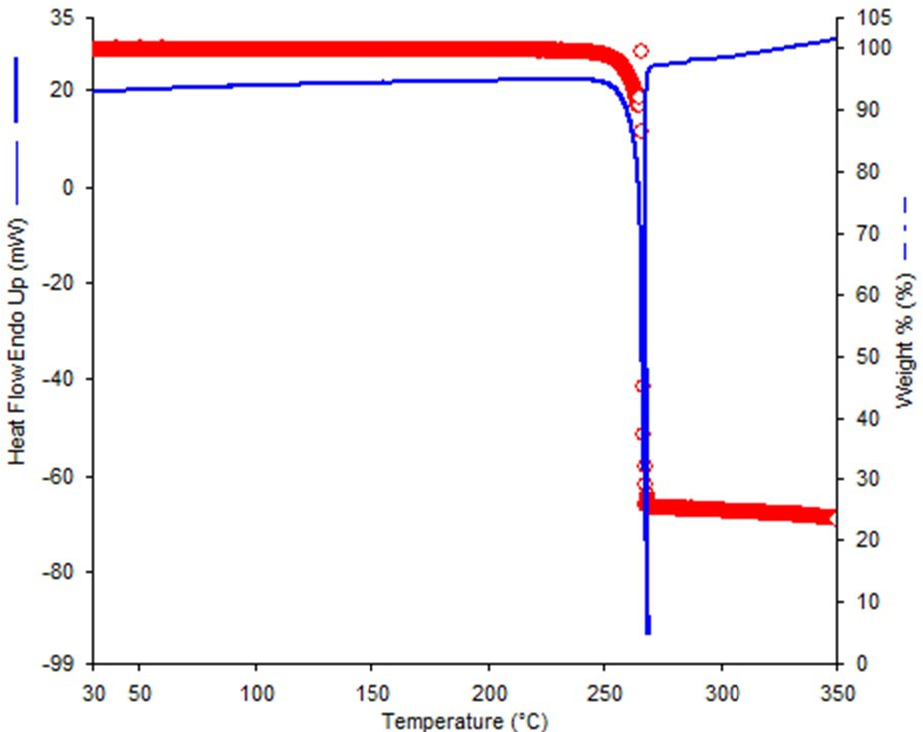
Figure 10. Termogravimetric analysis of 5-MeN(NO 2 )DNBO ( 3 ), 5-methylnitramino-4,6-dinitro-1,3-dihydrobenzimidazol-2-one at 5 °C/min. (DSC, blue line; TGA, red line).